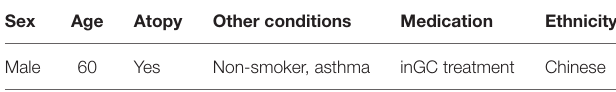
TABLE 1A | Nasal epithelium donor